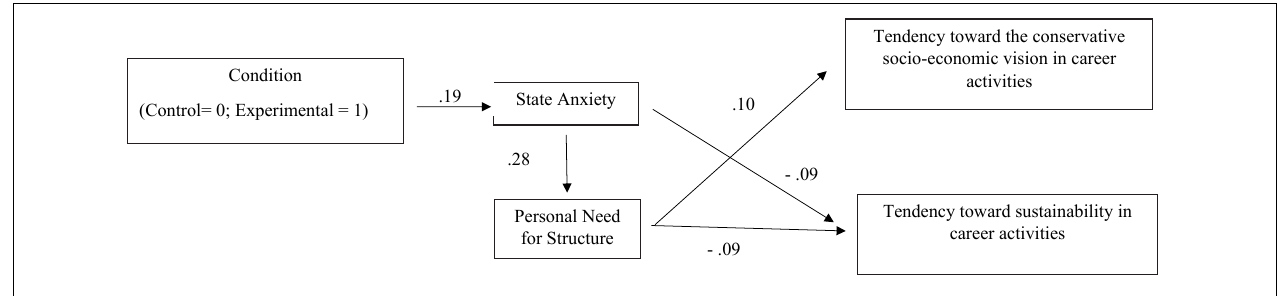
FIGURE 1 | Standardized parameter estimates in the model tested. Solid lines indicate statistically significant effects. TABLE 2 | Standardized direct and indirect effects of condition on tendency toward the conservative socioeconomic vision in career activities and tendency toward sustainability in career activities via state anxiety and the personal need for